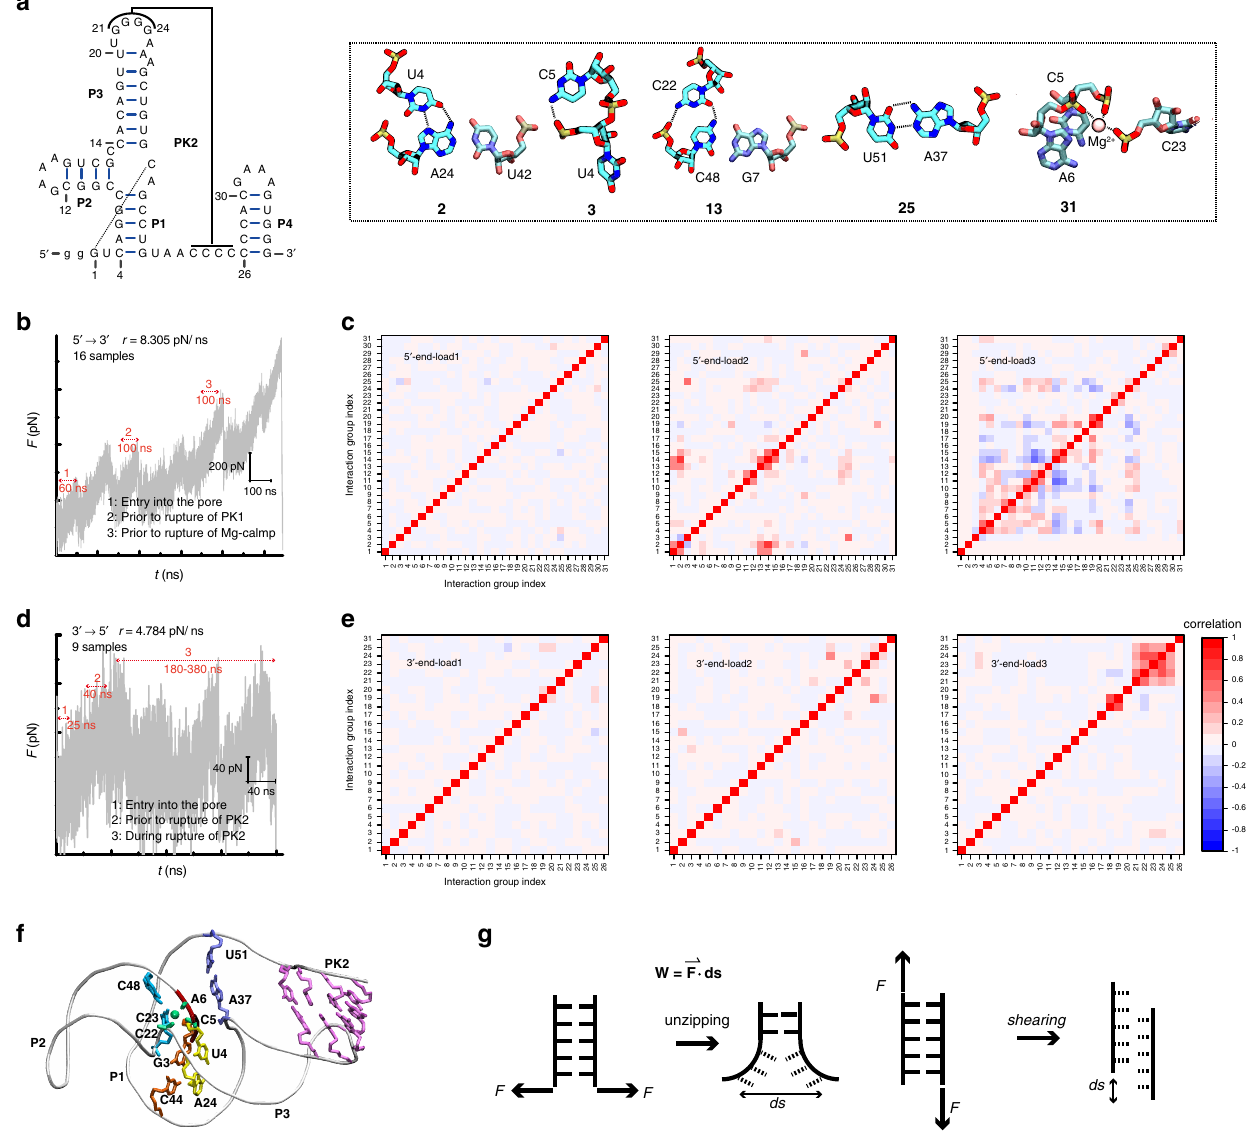
Fig. 7 Structural origin of the mechanical anisotropy of ZIKV xrRNA1. a The interactions (native HBs and Mg 2 + clamps) belonging to the same residue – residue pair are combined into a group, which is renumbered according to the secondary structure (left). A detailed view of non-canonical base pair interactions as well as the Mg 2 + clamps is also included. b , d De fi nition of different loading stages for 5 ′ -end pulling ( b ) and 3 ′ -end pulling ( d ). c , e Correlation analysis of residue – residue interaction for 5 ′ -end pulling ( c ), 3 ′ -end pulling ( e ) at 3 different loading stages. f The intricate interaction network (or force-bearing structure) in the center of ring structure is showed in bonds, which is proposed to be responsible for the stronger mechanical resistance of xrRNA1 to 5 ′ -end loading, whereas the 5 ′ -stretch and PK2 enclosing the ring are highlighted in red and cyan, respectively. g Schematic illustration of shearing mode and unzipping mode. Source data for c and e are provided as a Source Data fi